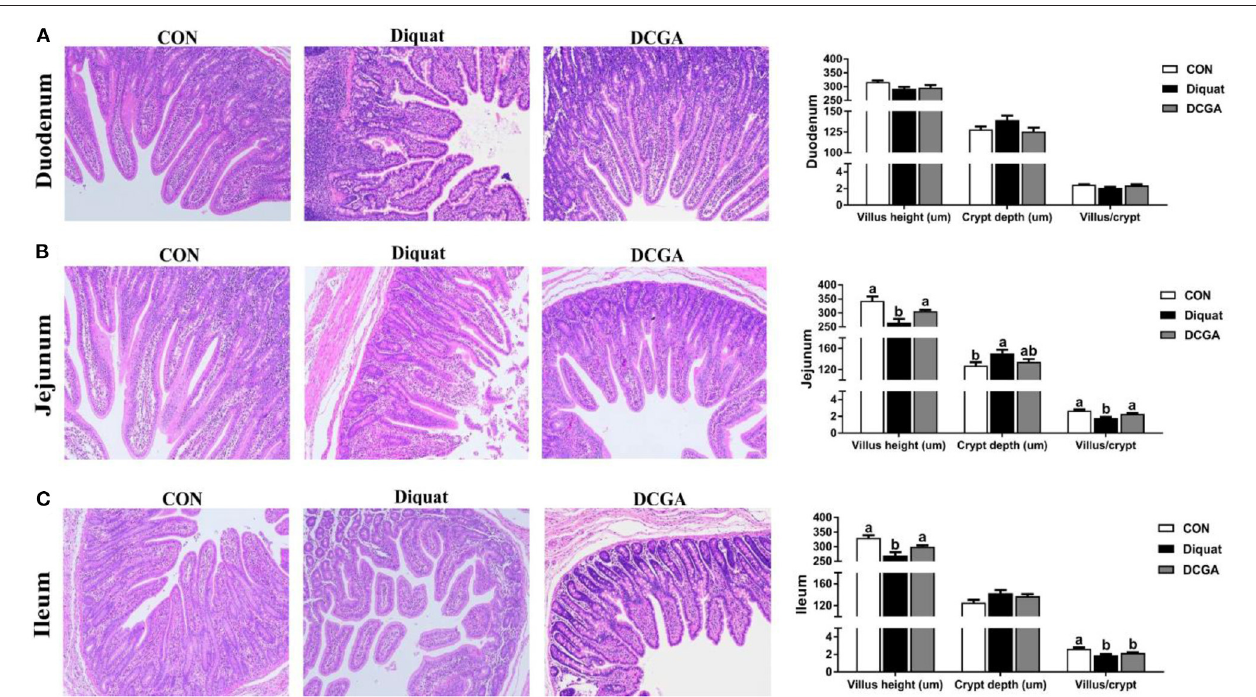
FIGURE 2 | Effects of CGA on intestinal morphology in the Duodenum (A) , Jejunum (B) , and Ileum (C) of piglets upon oxidative stress. CON, piglets fed a basal diet; diquat, piglets fed the basal diet and challenged by diquat; DCGA, piglets fed the basal diet containing CGA (1,000 mg/kg) and challenged by diquat.